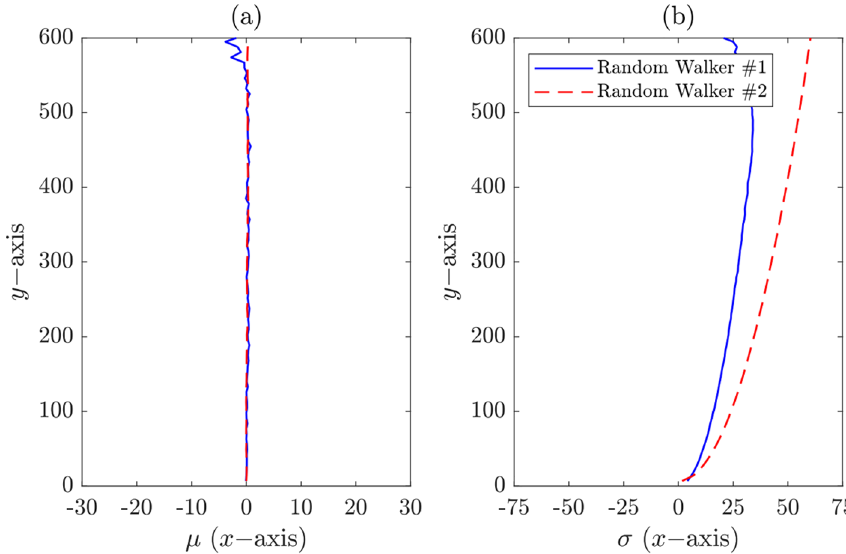
Figure 15. ( a ) Mean and ( b ) standard deviation (only σ + shown) of probability distributions at different y -levels.